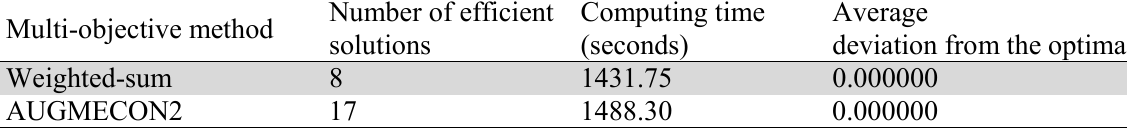
Results for the first scenario and twenty grid points. Multi-objective method